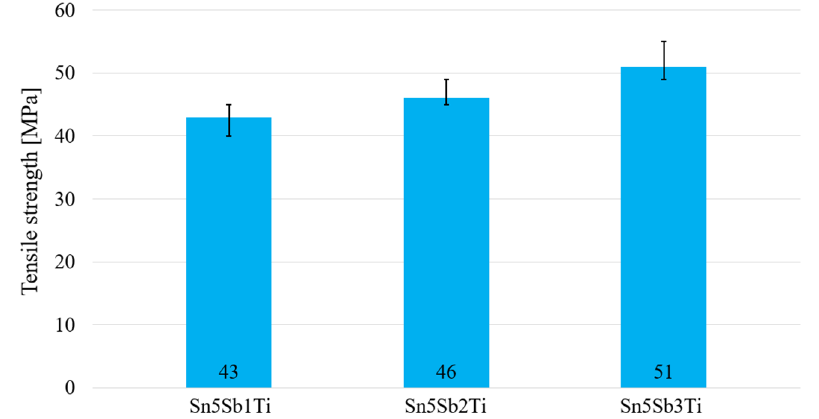
Figure 15 . Tensile strength of soldering alloys of the type Sn5Sb1-3Ti . Figure 15. Tensile strength of soldering alloys of the type Sn5Sb1-3Ti.